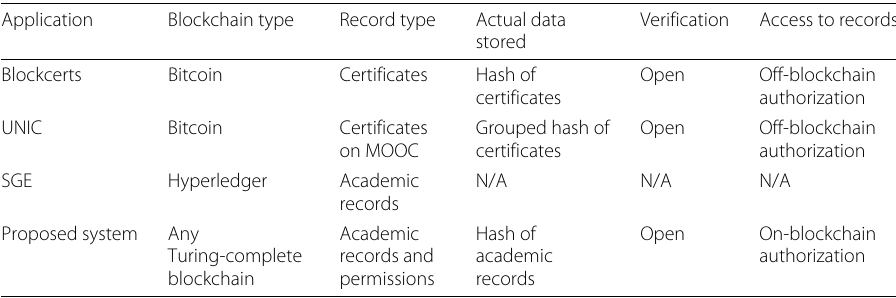
Table 1 Features of current applications of blockchain in